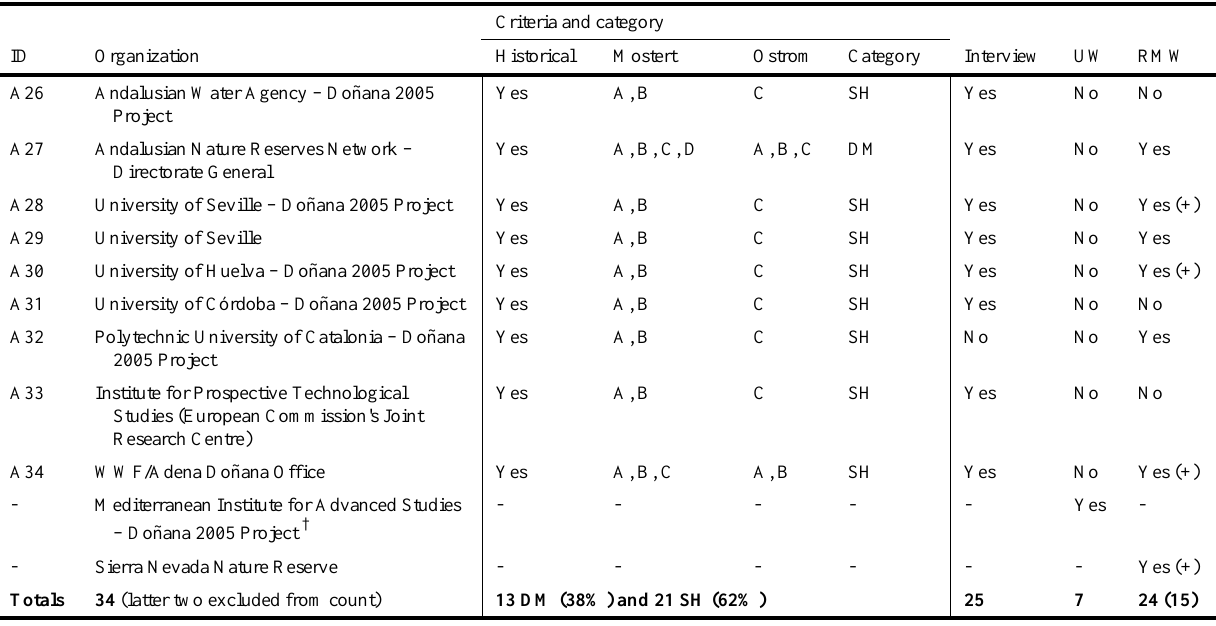
Table A2.2 (cont’d) . Identified actors (UW = uncertainty workshop, RMW = research-management workshop, DM = decision maker, SH =